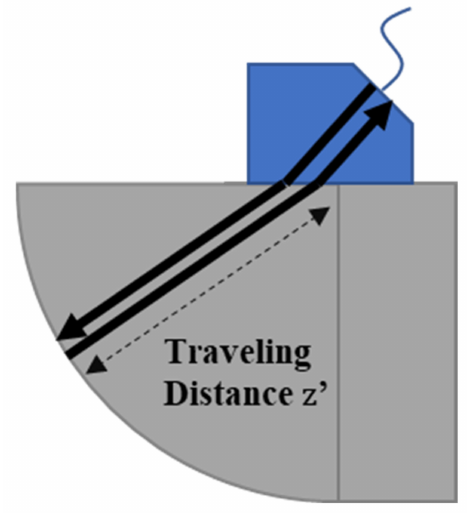
Figure 6. Schematics of experiment setup to obtain reference